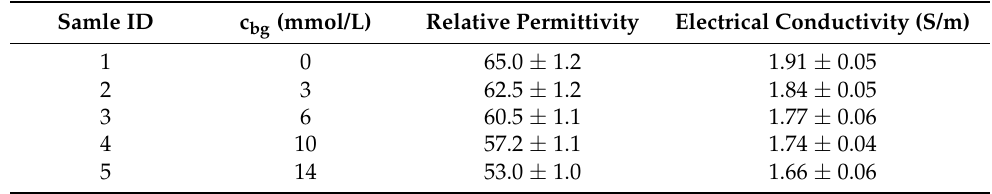
Figure 5. Measured values of electrical conductivity. Table 5. Measured values of DAK at 2